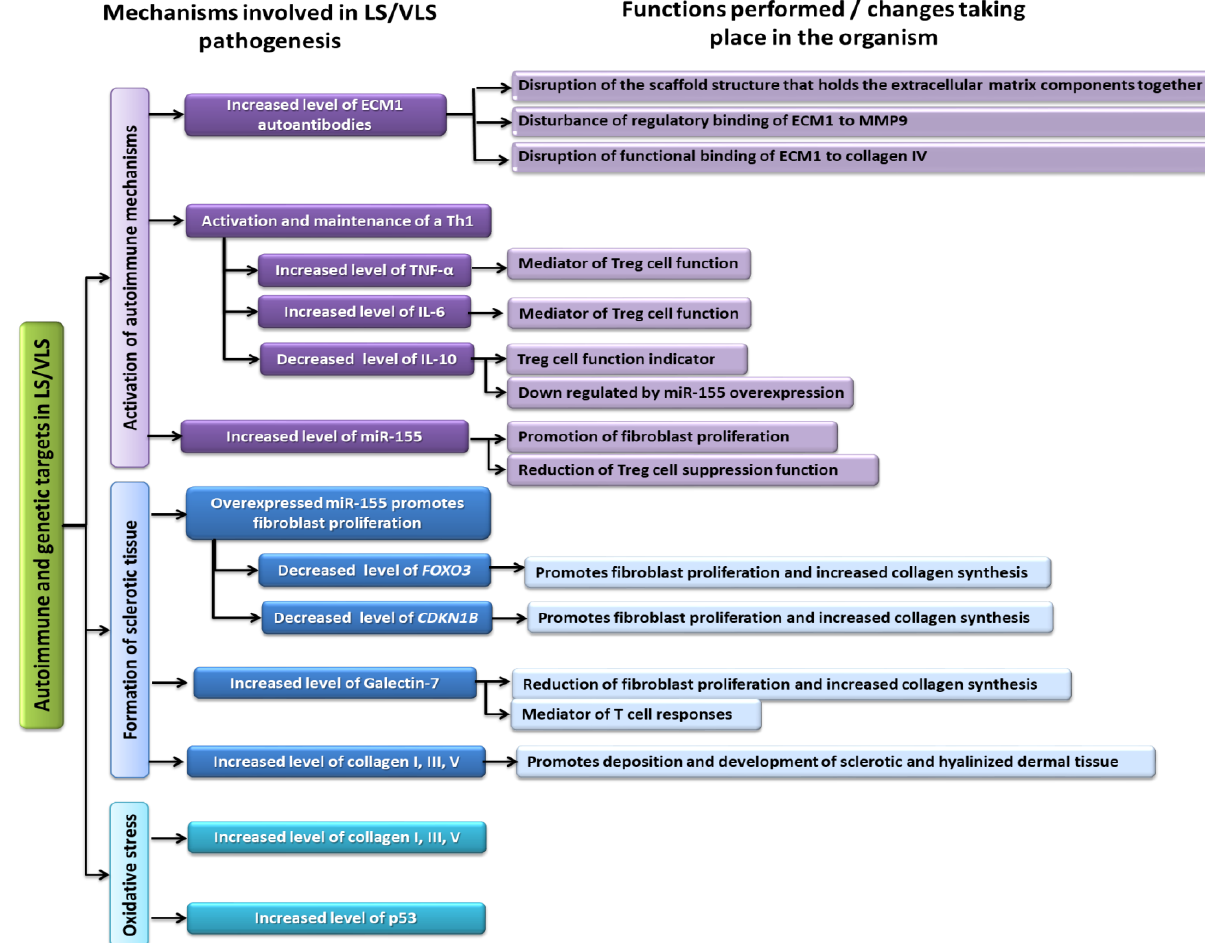
Figure 5. Schematic presentation of LS autoimmune and genetic targets based on [16,60]. ECM1 — extracellular matrix protein 1; CDKN1B — cyclin-dependent kinase inhibitor 1B; FOXO3 — forkhead tracellular matrix protein 1; CDKN1B—cyclin-dependent kinase inhibitor 1B; FOXO3—forkhead box O3; box O3; CDKN2A — cyclin-dependent kinase inhibitor 2A; MMP9 — matrix metallopeptidase 9; CDKN2A—cyclin-dependent kinase inhibitor 2A; MMP9—matrix metallopeptidase 9; p53—protein p53 — protein 53.